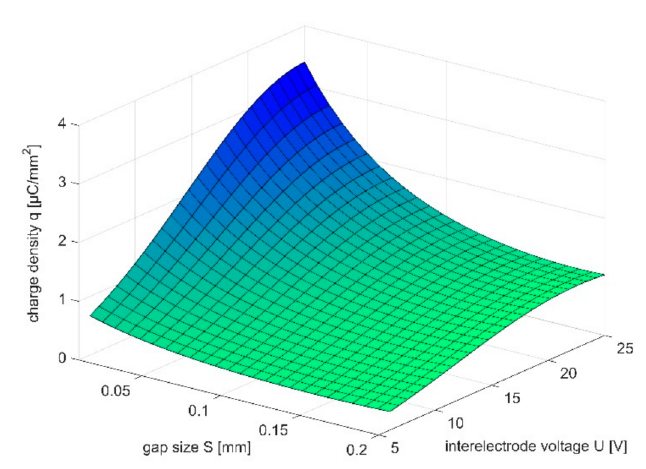
Figure 10. Relation q ( S , U ) for 0.1 M water solution of H 2 SO 4 as electrolyte.